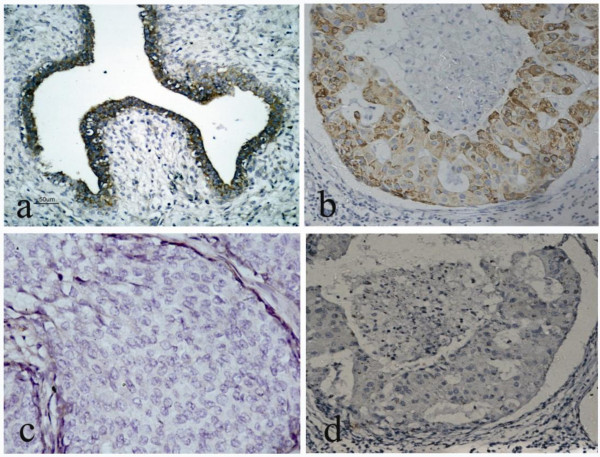
Expression of miR-339-5p in breast tissue specimens. Paraffin blocks from breast cancer or benign tissue specimens were prepared for making tissue microarrays, and the sections from the latter were hybridized with miR-339-5p probe in situ hybridization. A. Positive expression of miR-339-5p in a breast fibroadenoma. B. Positive expression of miR-339-5p in an invasive ductal carcinoma without lymph node metastasis. C. Negative expression of miR-339-5p in an invasive ductal carcinoma with lymph node metastasis. D. Negative control probe in an invasive ductal carcinoma. Magnification: ×200.